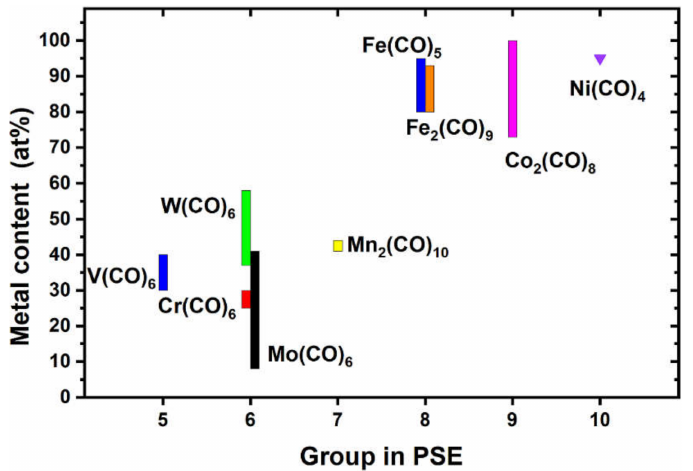
Figure 8. The maximum metal contents for FEBID deposits derived from homometallic carbonyls were deduced from the literature [12,13,23,47–58] and complemented by the results in this study. The V metal content is considered based on approximations of the oxygen